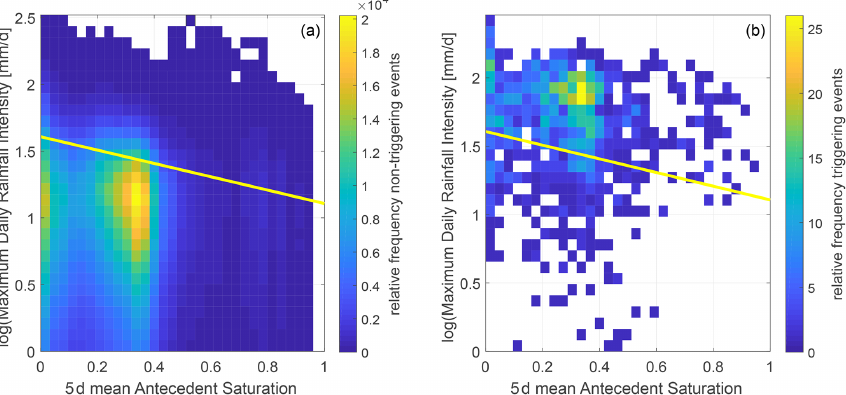
Figure 7. Relative frequency plot of triggering (b) and non-triggering (a) events for the hydrometeorological threshold combining 5d mean antecedent saturation and the logarithm of maximum daily intensity. The threshold leading to the highest TSS is indicated with a yellow